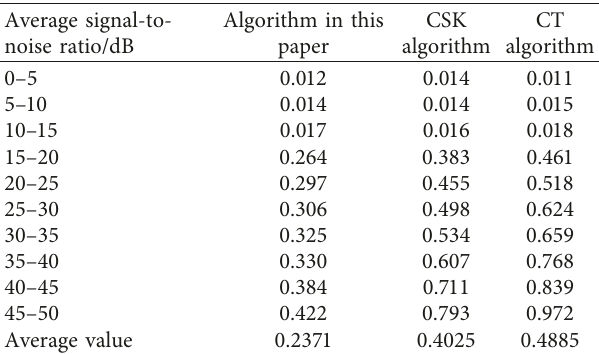
Figure 2: Comparison of efficiency of different tracking algorithms. (a) Comparison of iterations. (b) Time consumption contrast. Table 6: Comparison of average outage probability of different location systems.